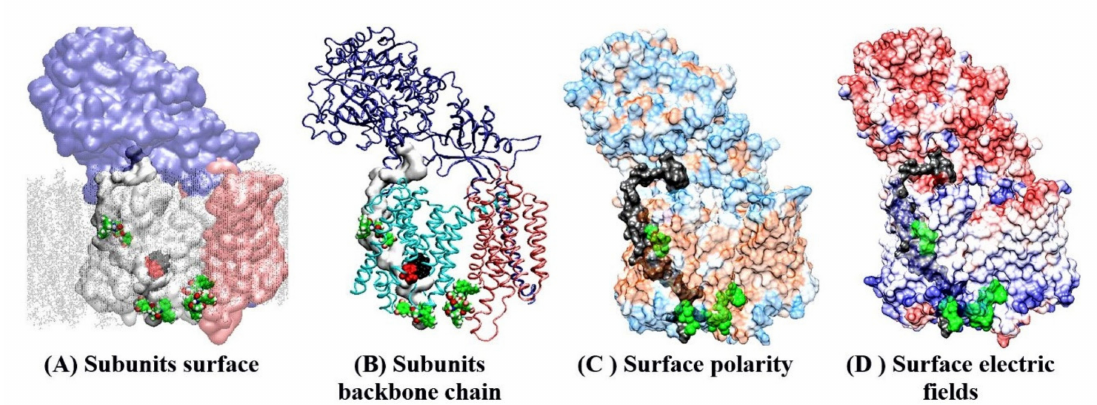
Figure 4. ( A – D ) Docking sites for semagacestat on the γ -secretase structure in a complex with its substrate (PDB:6IYC) [38]. Molecular docking studies showed that as many as four semagacestat molecules (green) can bind to γ -secretase simultane- ously in the presence of the substrate. One drug molecule binds at each end of the active site tunnel; two drug molecules are buried in the gap between presenilin and the Aph1 subunit. Transparent protein surfaces are used to show the structures buried in the protein interior. Four different presentations show the position of the drug-binding sites relative to the main structural elements in the γ -secretase complex. ( A , B ) Different subunits are shown: nicastrin, cyan; presenilin, white or light blue; Aph1, pink; substrate, gray; the membrane is shown as dots. The drugs bind to presenilin sites inside and outside of the membrane. Buried underneath the protein surface is the substrate (depicted as a gray surface), the active site Asp 257 and Asp 385 (red), and the adjacent PAL motif (black, Pro 435, Ala 434, Leu 433) [42]. ( C ) The protein surface is colored based on its polarity: blue, polar; brown, hydrophobic; white, amphiphilic. The substrate is shown as a black surface, and it marks the position of the active site tunnel. ( D ) Adaptive Poisson-Boltzmann Solver APBS analysis of electric fields on the protein surface: blue, positive; red, negative; white, neutral [50]. The electric fields show that γ -secretase is a polarized molecule. The negative field dominates on the nicastrin side of the membrane, while the positive field dominates the cytosolic site. The positive N-terminal of the substrate matches the negative field on nicastrin. The negative C-terminal on the nascent A β catalytic intermediates matches the positive field at the cytosolic side of the protein. Dynamic electric fields can be a crucial part of enzyme–substrate recognition and the processive cleavages of the A β catalytic intermediates